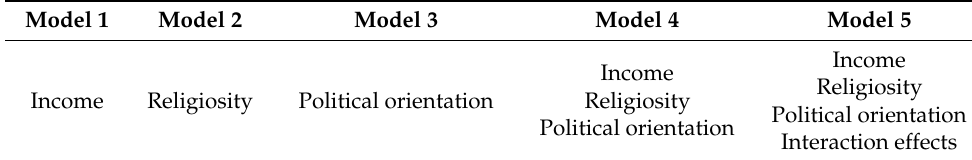
Table 3. Independent variables by model.